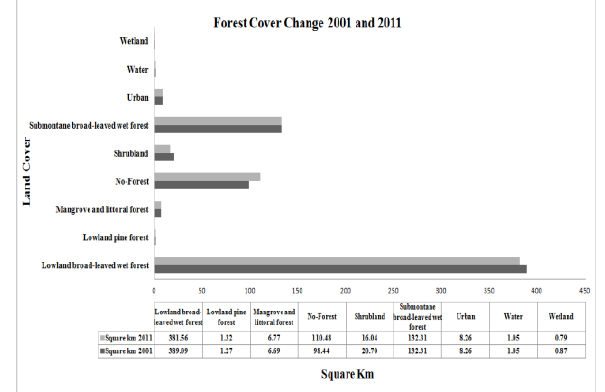
Figure 4. Rio Grande watershed land cover change from